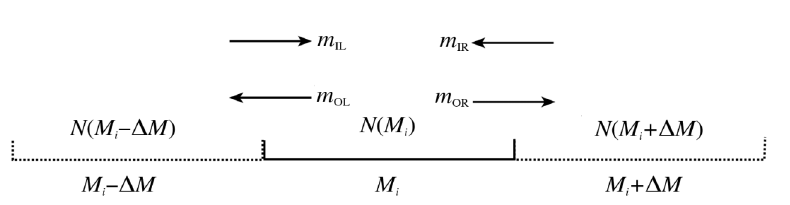
Fig. 5. Effect of the measurement errors on the number of earthquakes with binned magnitude M i . Adding the measurement errors, the number of events that come into the bin with central magnitude M i from the adjacent left bin is m IL , while those coming from the adjacent right bin is m IR . The number of events that go out of the bin with central magnitude M i towards the adjacent left bin is m OL , while those going out towards the adjacent right bin is m OR